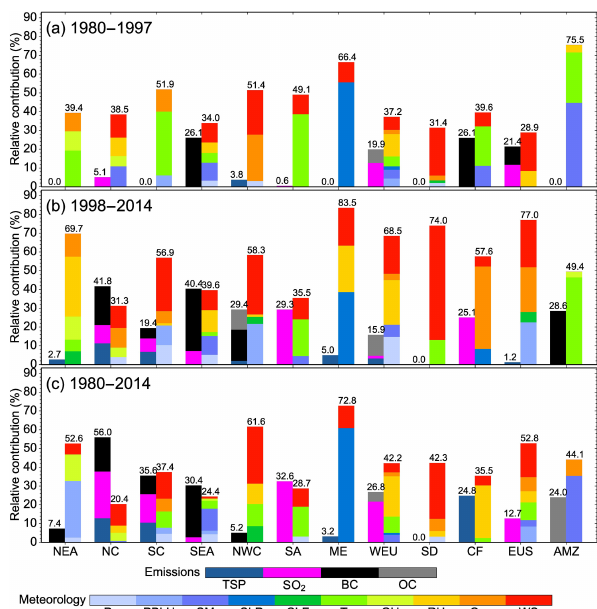
Figure 13. The LMG method-estimated relative contributions (%) of total variances in the stepwise MLR model explained by the lo- cal emission factors (left-hand bars) and meteorological variables (right-hand bars) over the 12 regions of interest during three pe- riods: (a) 1980–1997, (b) 1998–2014 and (c) 1980–2014. Note that meteorological parameters were combined as follows: tem- perature, T ( T s , T 850 , T 700 , T 500 , d T 900 − s , d T 850 − s ); geopotential height, GH (GH 850 , GH 700 , GH 500 ); relative humidity, RH (RH s , RH 850 , RH 700 , RH 500 ); vertical velocity, Ome (Ome 850 , Ome 700 , Ome 500 ); and wind speed, WS ( U 850 , U 700 , U 500 , V 850 , V 700 , V 500 , WS s , WS 850 , WS 700 , WS 500 , VWS 500 − 850 ). Refer to Ta- ble S3 for the detailed relative contributions of each variable in the stepwise MLR